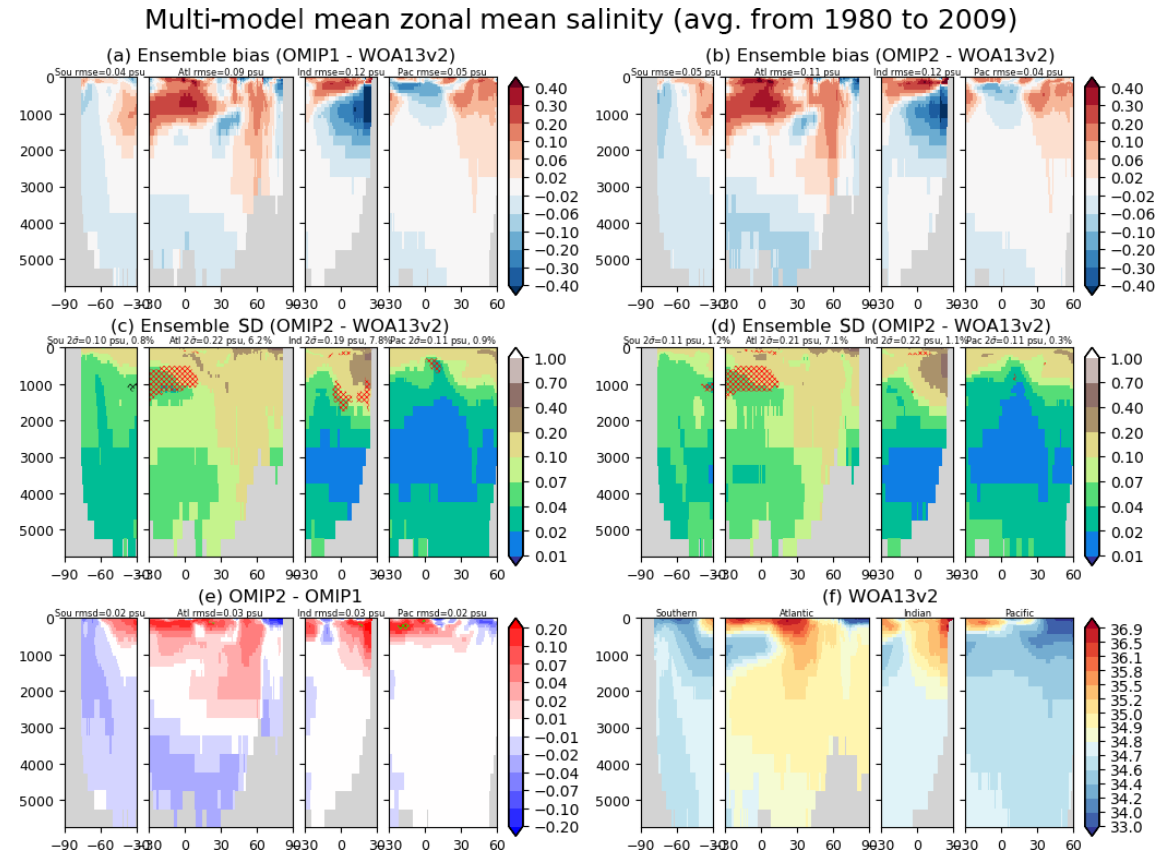
Figure 14. Panels (a) and (b) show biases of multi-model mean, 30-year (1980–2009) mean basin-wide zonally averaged salinity of the last cycle relative to WOA13v2 (Zweng et al., 2013) for (a) OMIP-1 and (b) OMIP-2. Panels (c) and (d) show the standard deviation of the ensemble, with the regions where the observation is outside the 95% confidence range of the model spread ( ± 2 σ ) hatched with red. (c) OMIP-1 and (d) OMIP-2. (e) Difference of 30-year (1980–2009) mean basin-wide zonal mean salinity between OMIP-2 and OMIP-1 (OMIP-2 minus OMIP-1), with the regions where the difference is significant at 95% confidence level hatched with green as in Fig. 6. (f) Basin-wide zonal mean salinity of WOA13v2. Units are psu. At the top of each panel, basin mean values are depicted as in Fig. 13. See Figs. S36–S38 for results of individual